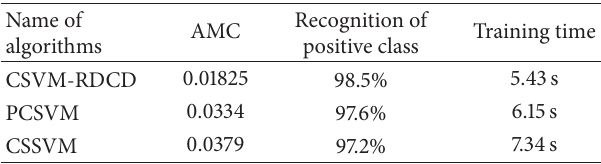
Table 4: Classification performance of three algorithms using CSVM on the